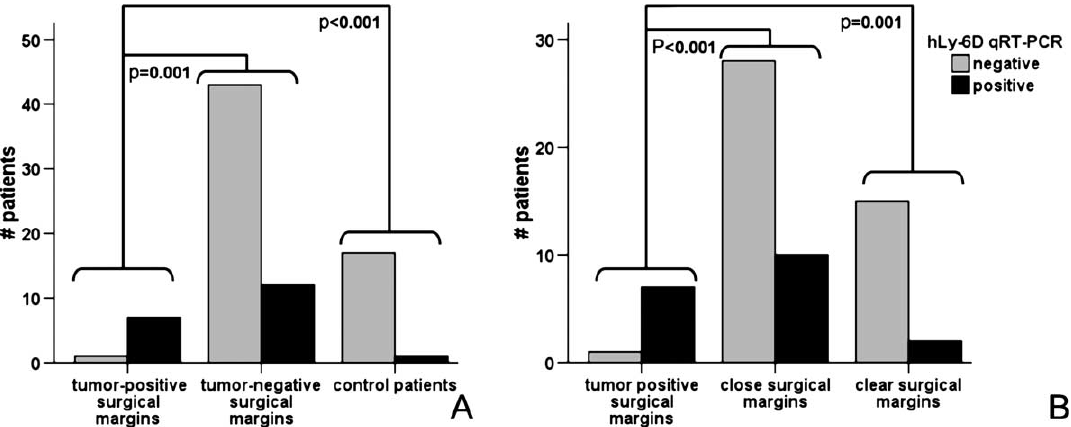
Fig. 3. Relationship between histopathological status of surgical margins and presence of hLy-6D qRT-PCR results. (A) On the x -axis the groups of HNSCC patients are shown with either tumor-positive surgical margins, tumor-negative surgical margins. The number of patients with either positive (black bars) or negative (grey bars) OR-samples as determined by hLy-6D qRT-PCR is indicated on the y -axis. The non-diagnostic cases were excluded. The groups were compared with each other using chi-square tests. p -values below 0.05 were considered significant. (B) No significant difference was shown between the groups of patients with clear surgical margins ( (cid:2) 5 mm) and close surgical margins ( < 5 mm) ( p = 0 .